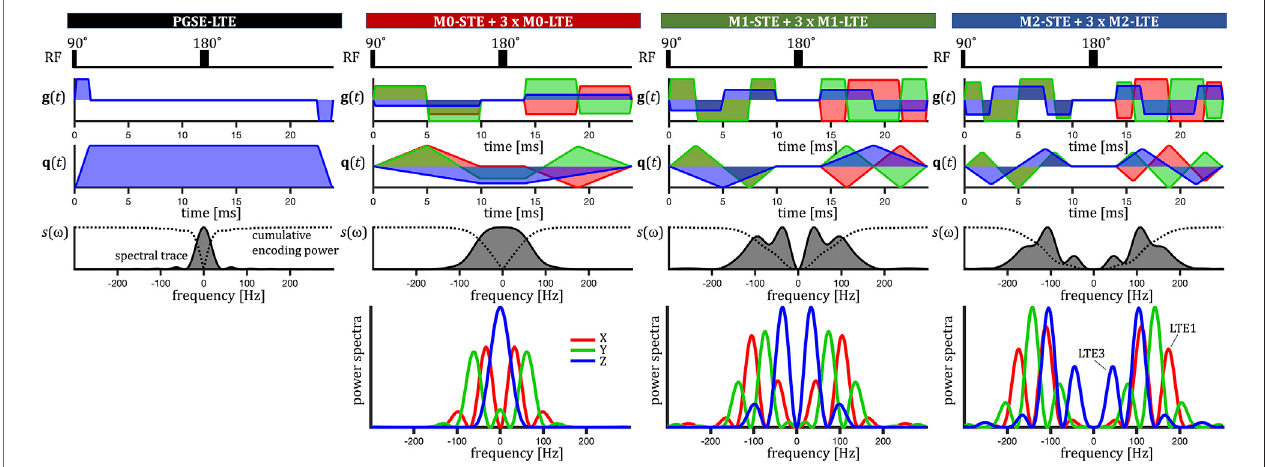
FIGURE 2 | Encoding on the preclinical scanner. Radio frequency (RF) pulses, effective gradient waveforms g ( t ), dephasing waveforms q ( t ), normalized spectral trace s ( ω ) (grey shaded) and diagonal componentsof the dephasing cross power spectral density. The normalized cumulative encoding power ~ b ( ω ) isshown asdotted line.Individual components (XYZ in red, green, blue)from M0-, M1-, M2-STE were used as M0-, M1-, M2-LTE. Their power spectra isshown below s ( ω ). In all cases the encoding time was τ = 24 ms. Note the shift of spectra from zero frequency to higher frequencies, which alters sensitivity to TDD. The STE components with most similar/different power spectra compared to the spectral trace are marked as